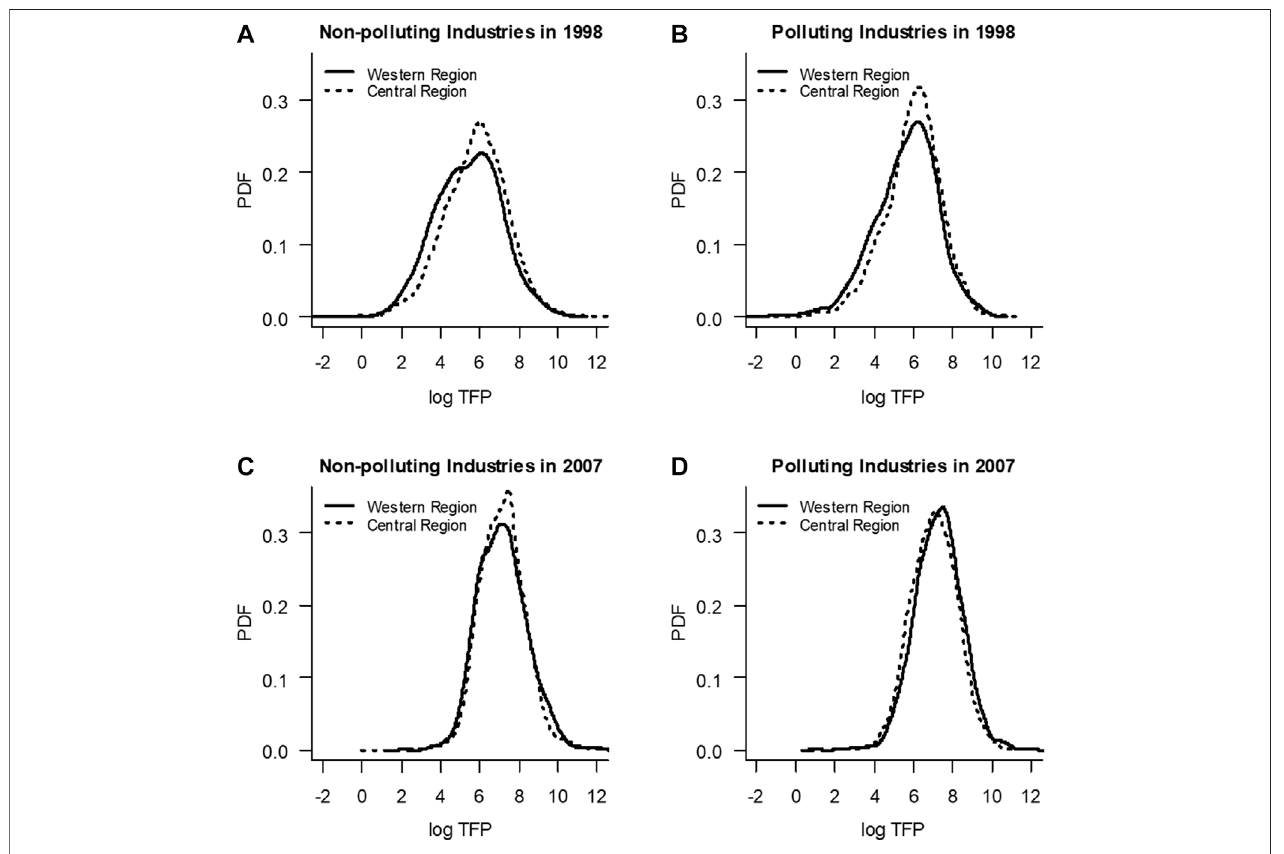
FIGURE 3 | Log TFP distributions before and after the